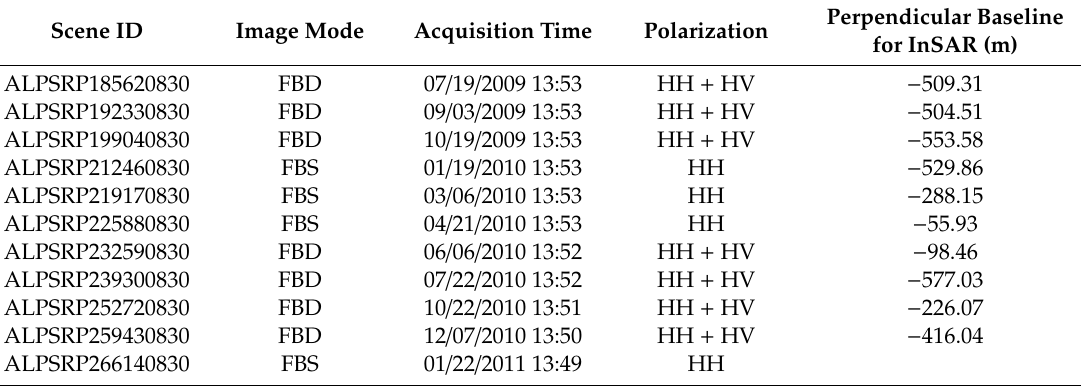
Table 1. Information of ALOS PALSAR images and InSAR pairs covering Mt. Baekdu test area. Note that the empirical value of critical baseline for InSAR pair is 13 km; thus all InSAR pair of this study have proper conditions for InSAR phase coherence formation as shown in perpendicular baseline